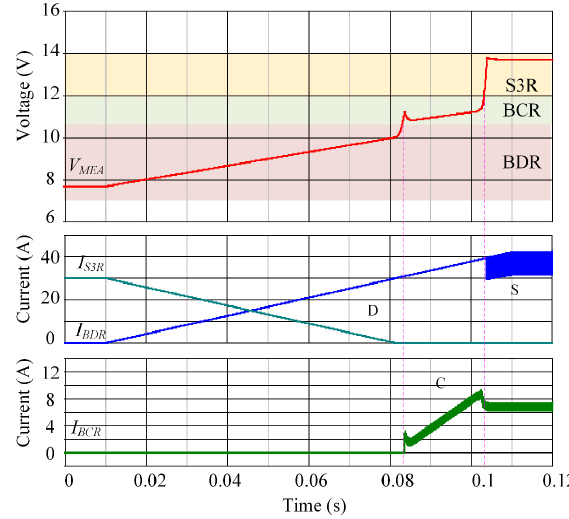
Figure 27. Waveforms of PCU with 30 kW constant power load during the earth eclipse period.